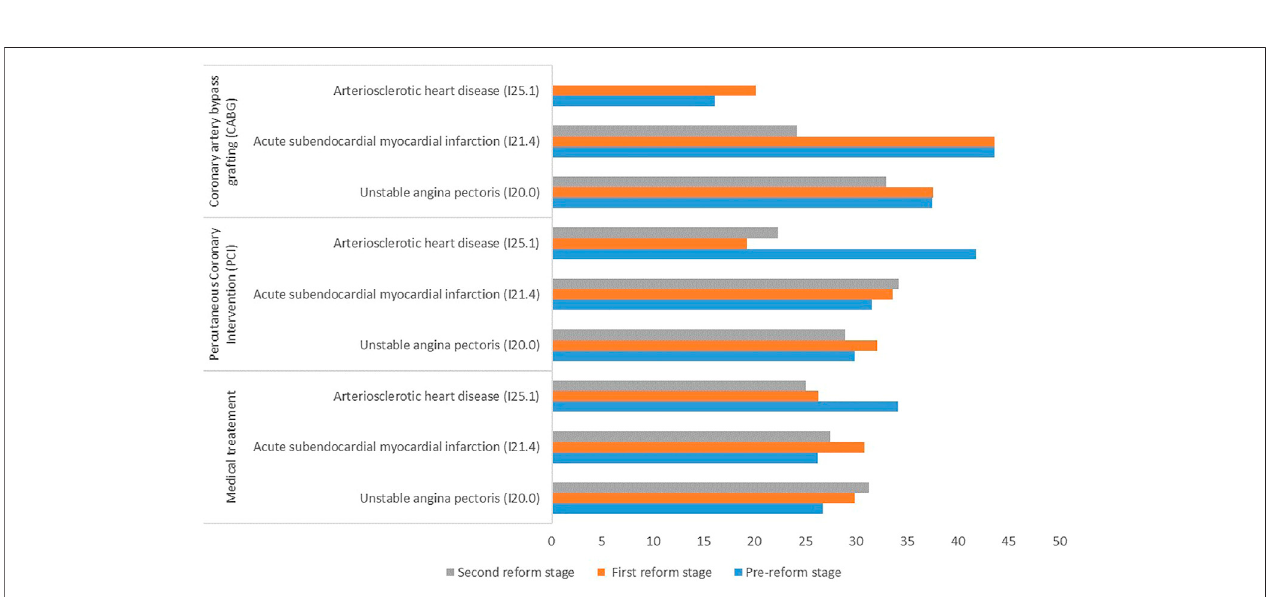
FIGURE 2 | Number of prescribed units of DHI uses among patients with different treatment methods and clinical types of coronary heart disease.